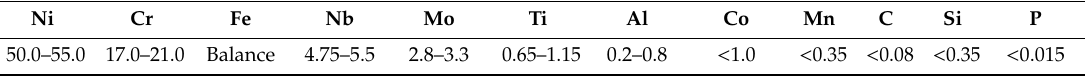
Table 1. The chemical composition of Inconel 718 (wt.